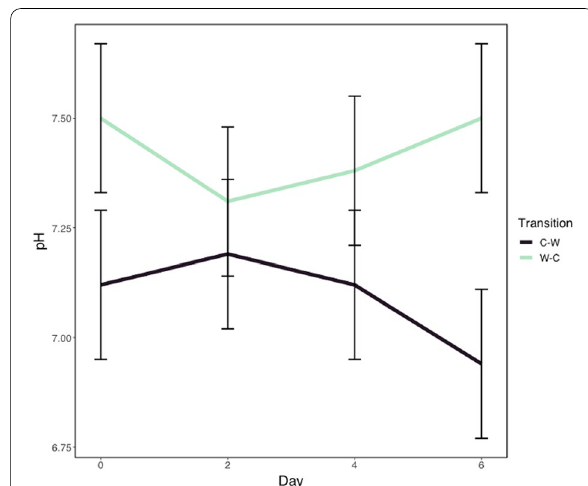
Fig. 5 Fecal pH following transitions between cool‑season and warm‑season grass. Fecal pH of horses across six days following transitions from cool‑season to warm‑season grass (C–W) and warm‑season to cool‑season grass (W–C) in both the bermudagrass integrated rotational grazing system and the crabgrass integrated system. There was an effect of transition and grazing system (mixed model ANOVA with Tukey’s post hoc adjustment; P 0.02), but pH ≤ did not differ by day. There were no significant interactions